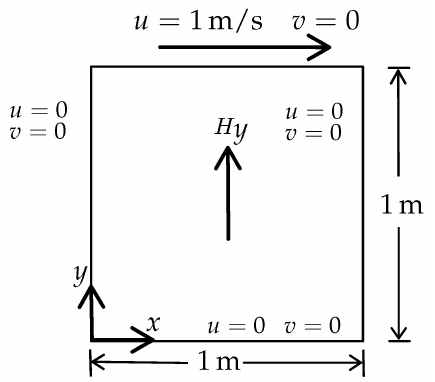
Figure 1. Schematic for the 2D lid-driven cavity